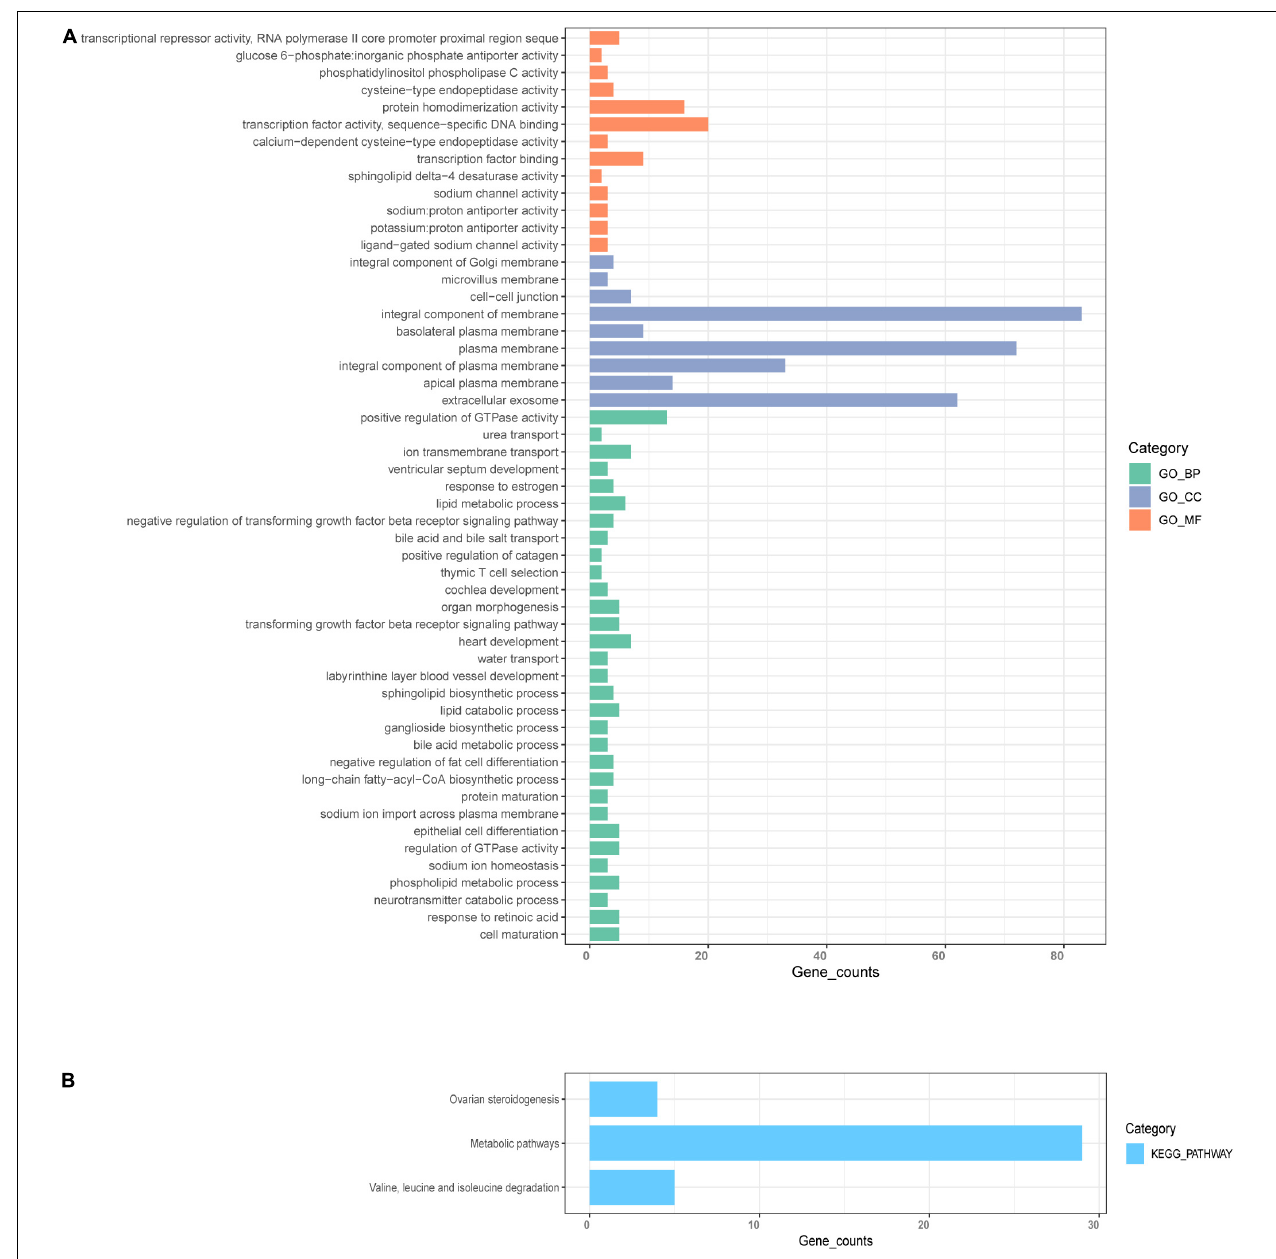
FIGURE 5 | GO and KEGG enrichment analysis. (A) GO analysis for genes in significant modules, including biological process (BP), cellular component (CC), and molecular function (MF). (B) KEGG enrichment analysis for genes in the significant modules.